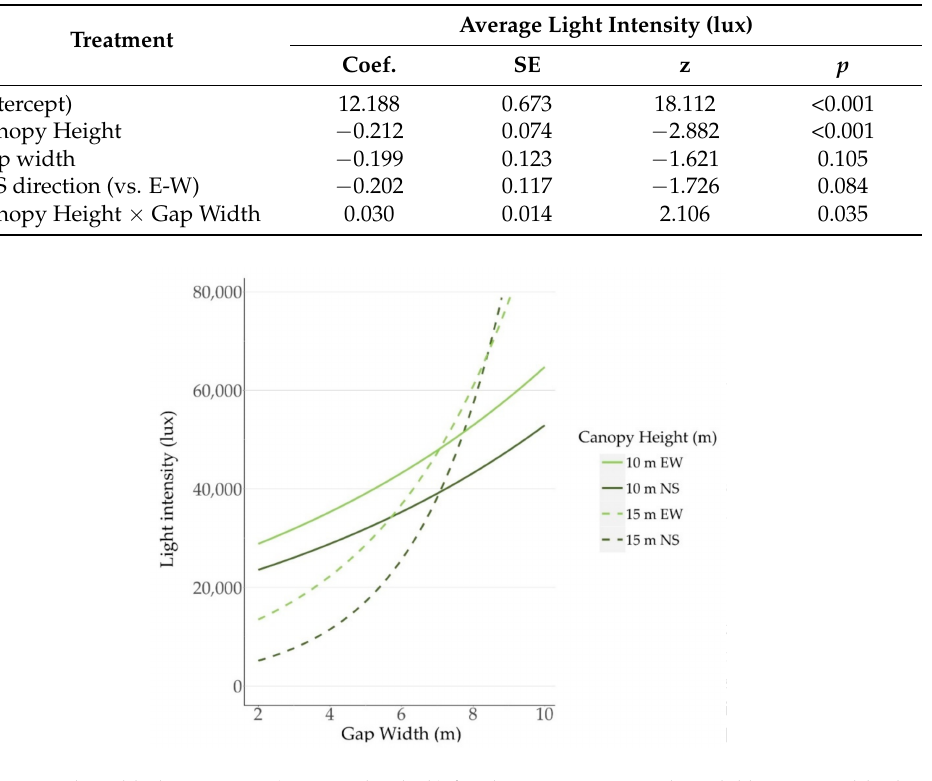
Table 3. Mixed effect regression (Gamma) model explaining light intensity (lux) on seismic lines as a function of canopy height, gap width, line orientation, and canopy height-to-gap width interaction. Model coefficients ( β ), Standard Error of the coefficients (SE), z-score (z), and significance ( p ) reported.